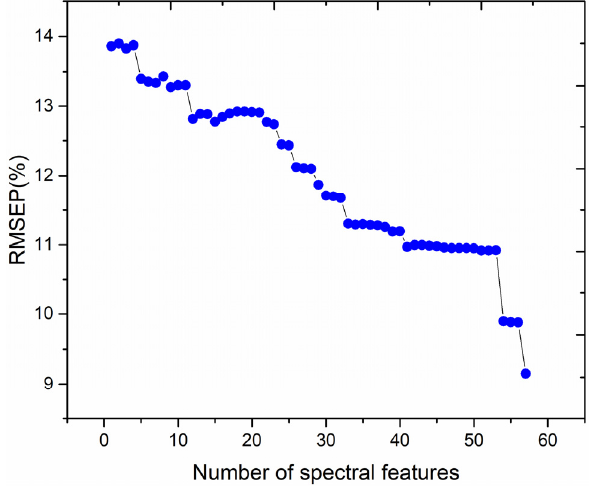
Figure 7. Effect of the number of spectral features on the performance of the PLSR quantitative analysis model.